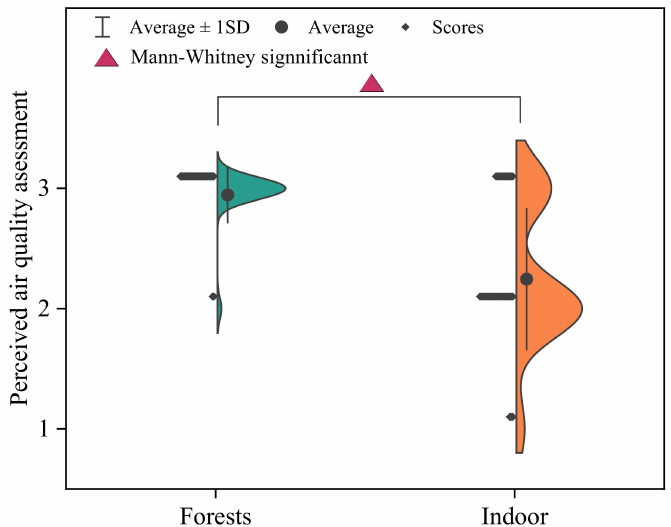
Figure 7. The score of perception air quality of air quality, where 3, 2, and 1 refer to good, neutral, and bad air quality, respectively.